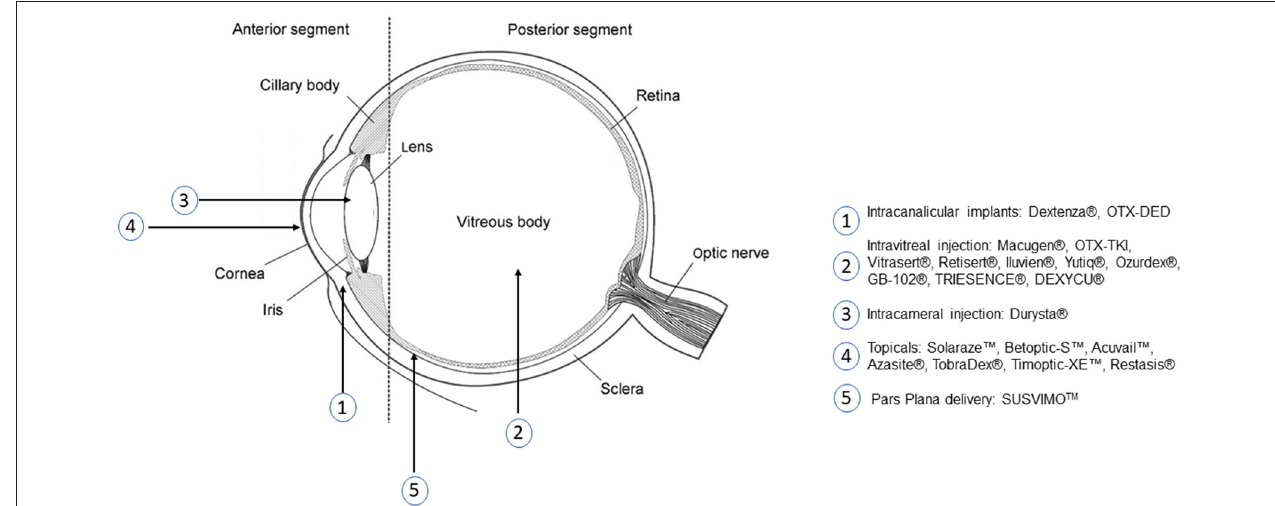
FIGURE 5 | Administration location of several FDA approved ocular drug delivery systems that use